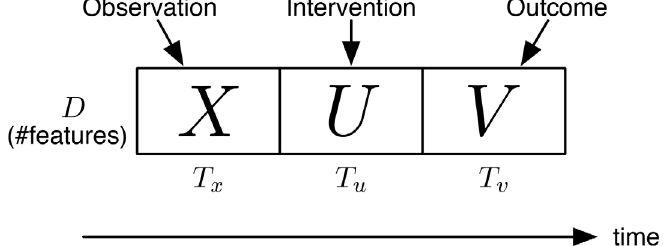
Fig 1. Illustration of the dynamics engineering problem. X : observation dynamics; U : intervention dynamics; V : outcome